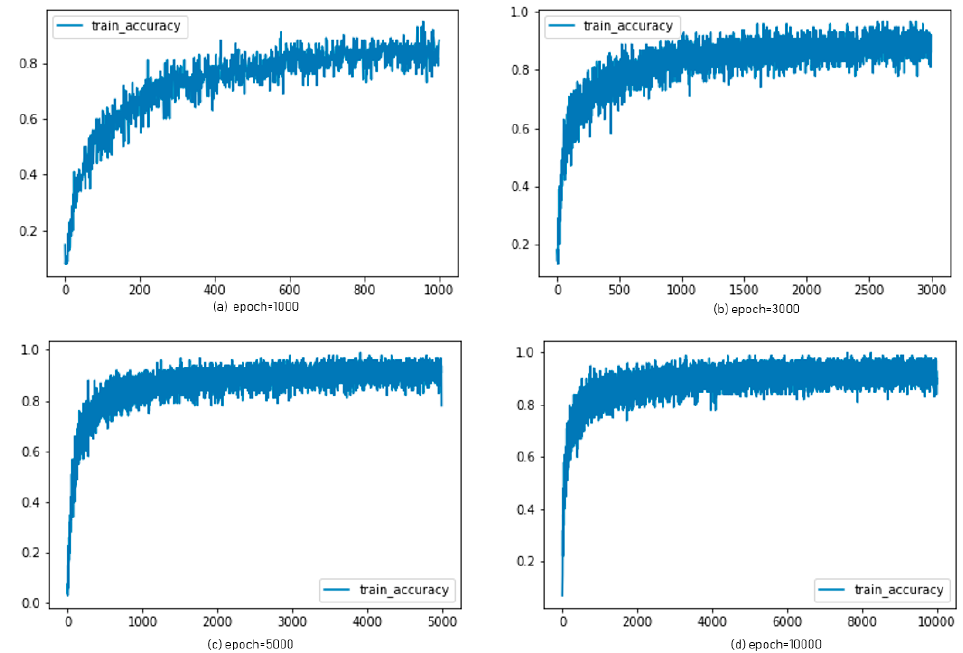
Figure 14. Experimental results: accuracy of AdaGrad for each epoch.